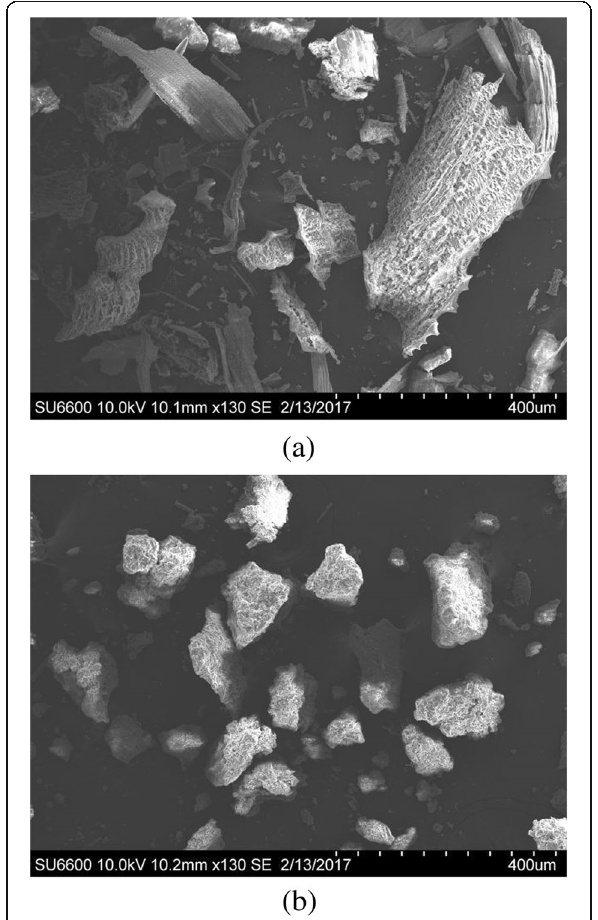
Fig. 2 Scanning electron microscopy (SEM) images of ( a ) RHA and